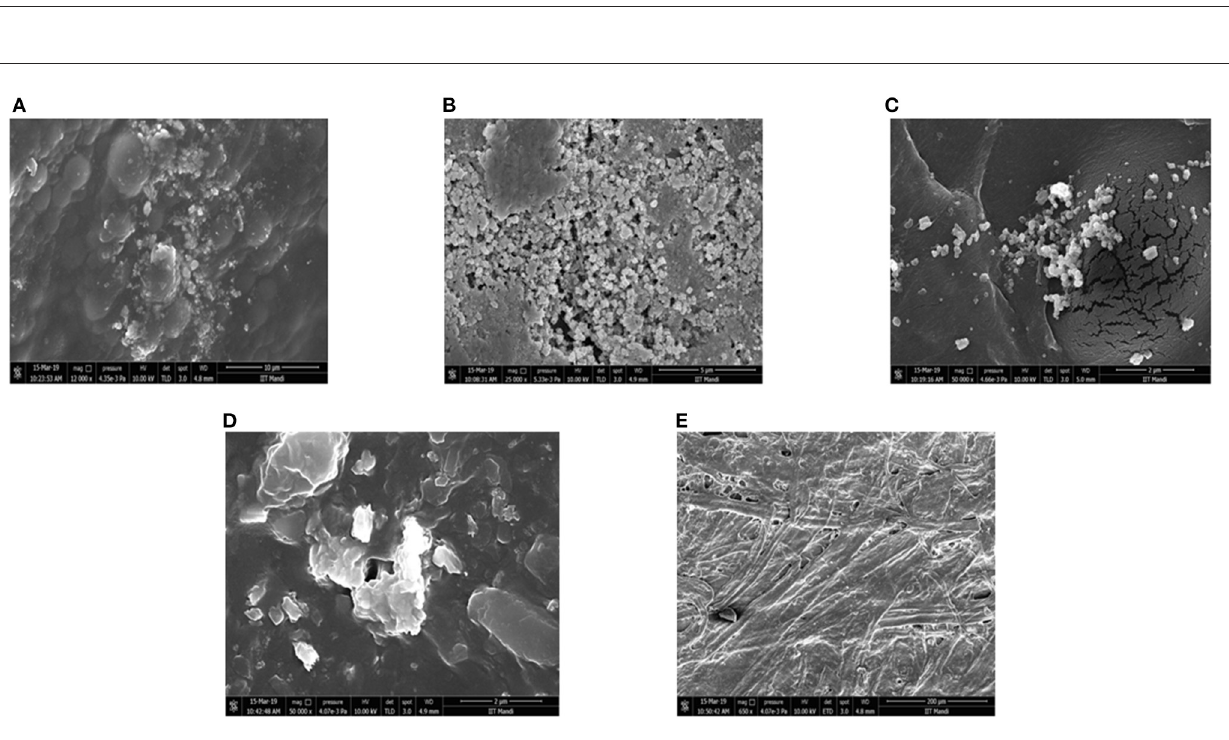
FIGURE5 SEM micrograph of different treatments coated cellulose paper (A) L. pentosus S6 AgNP (B) L. crustorum F11 AgNP (C) L. spicheri G2 AgNP (D) AgNO 3 coated paper (E) untreated